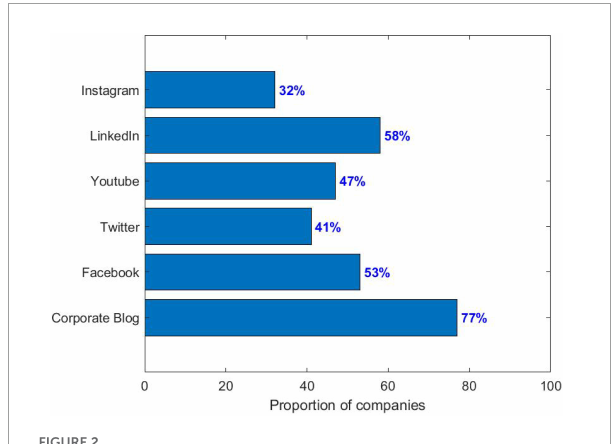
FIGURE2 Relative percentage use of different social media platforms in the energy and resources